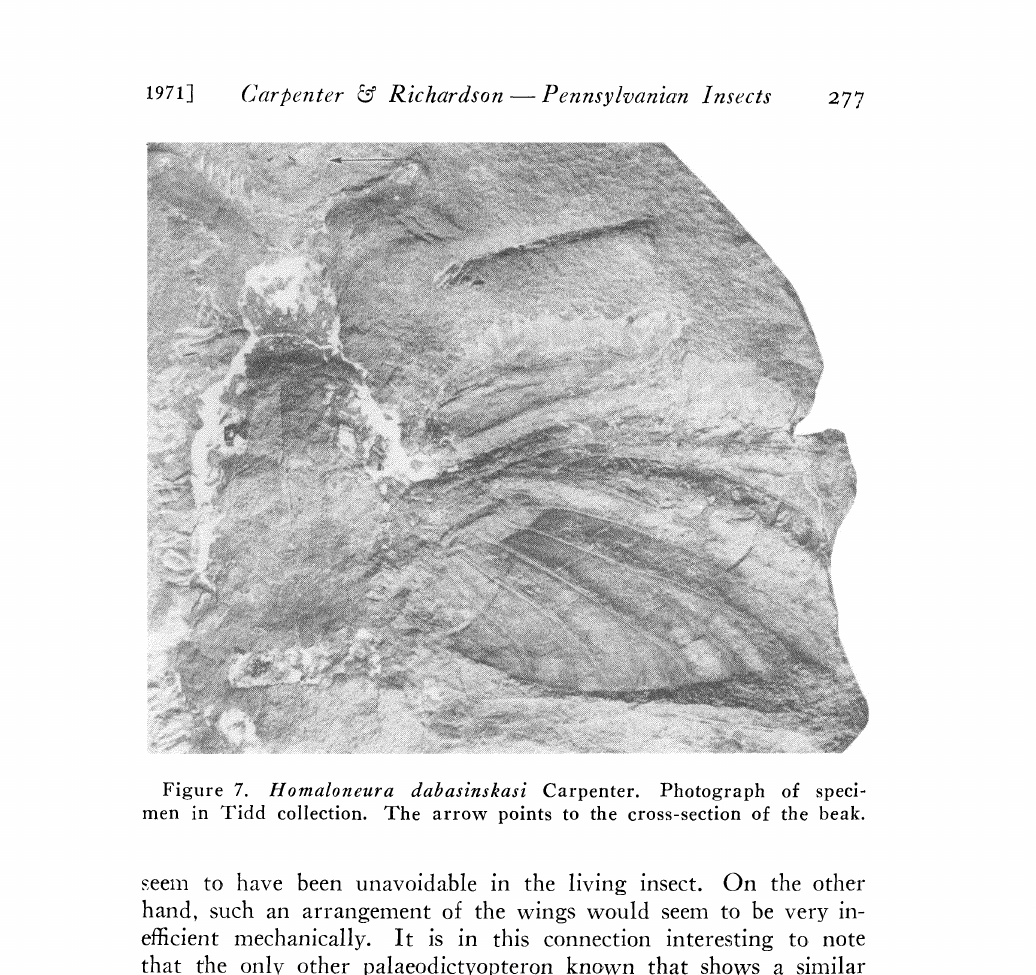
Figure 7. Homaloneura dabasinskasi Carpenter. Photograph of speci- men in Tidd collection. The arrow points to the cross-section of the beak. seem to have been unavoidable in the living insect. On the